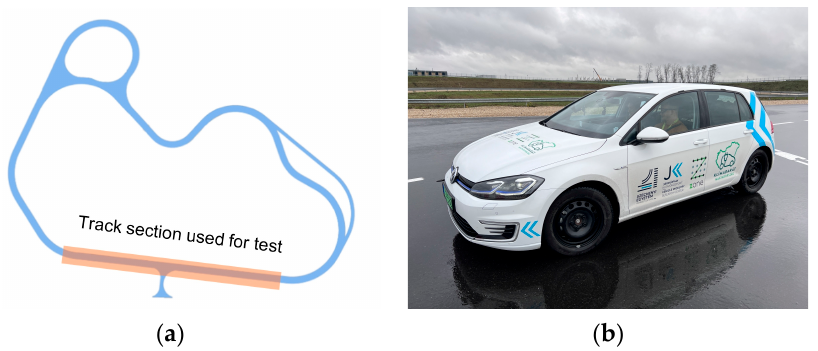
Figure 1. ( a ) 450 m long straight section of ZalaZONE “High-Speed Handling Course”; ( b ) Test vehicle: VW e-Golf.